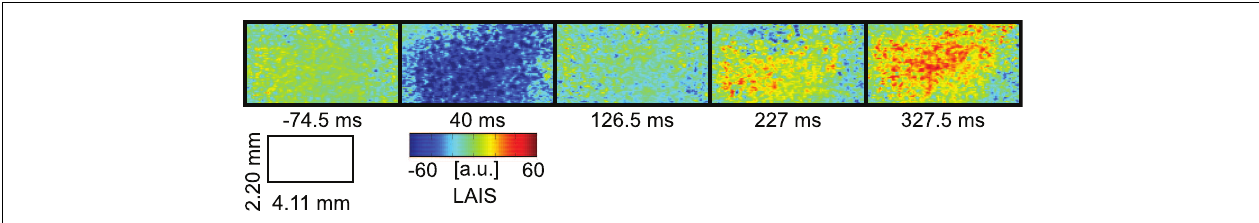
FIGURE 6 | LAIS inVSD data from cat visual cortex (area 18), before and after presentation of a visual stimulus at time t = 0ms . Modified fromWibral et al. (2014a); creative commons attribution license (BB CY